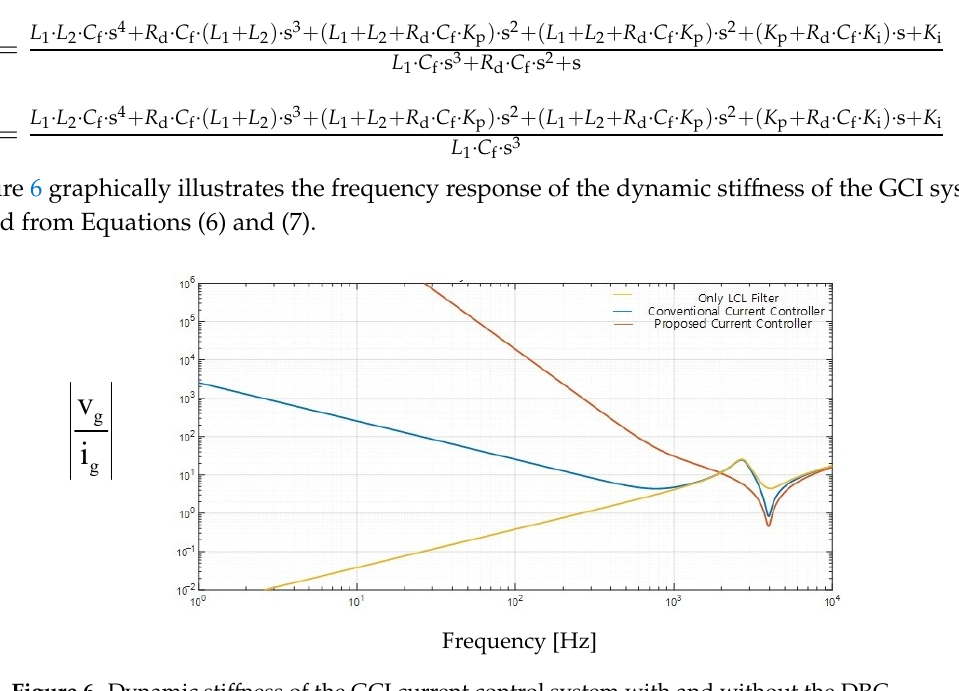
Figure 6. Dynamic stiffness of the GCI current control system with and without the DRC.